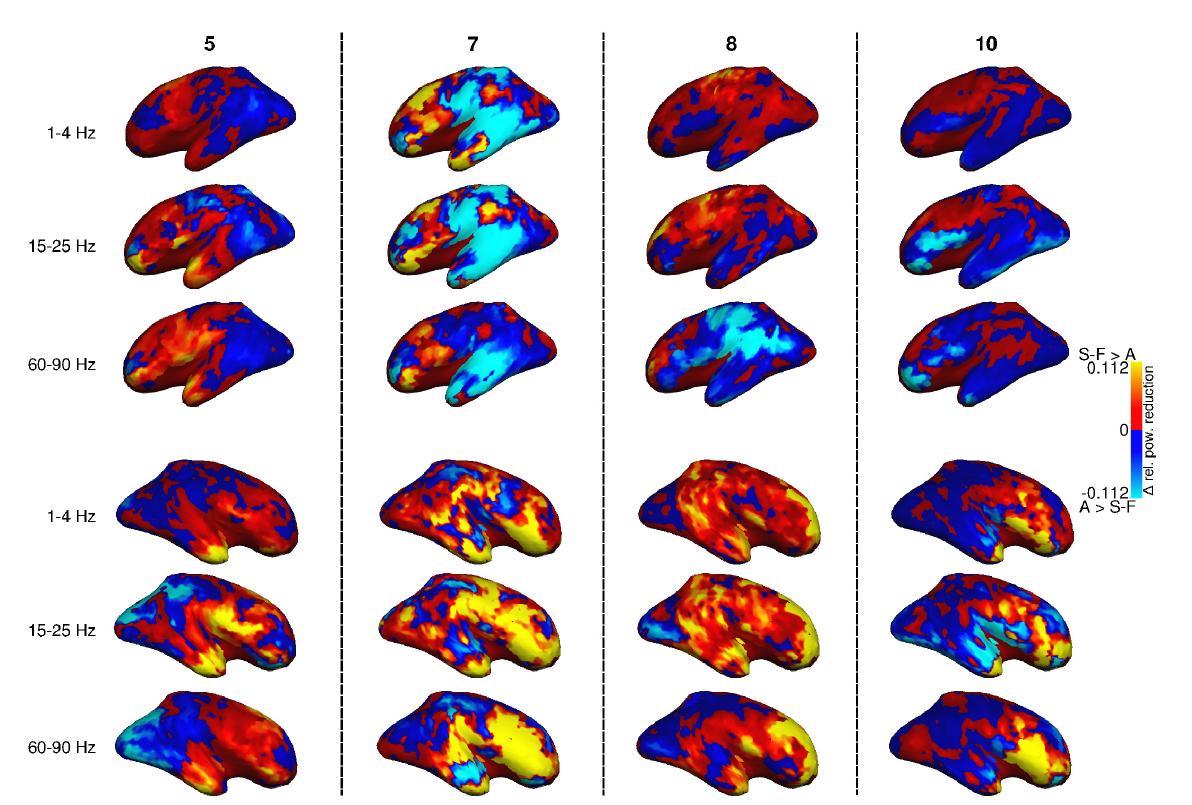
FIGURE4 Difference between power reduction by SOBI-FastICA and AMICA in four individual subjects (no. 5, 7, 8, and 10; cf. Table 1 ) for frequency bands 1–4, 15–25, and 60–90 Hz, relative to the power level of the AMICA pipeline. Red indicates areas where the SOBI-FastICA pipeline resulted in a larger reduction of signal power, whereas blue denotes areas where AMICA resulted in a larger reduction of signal